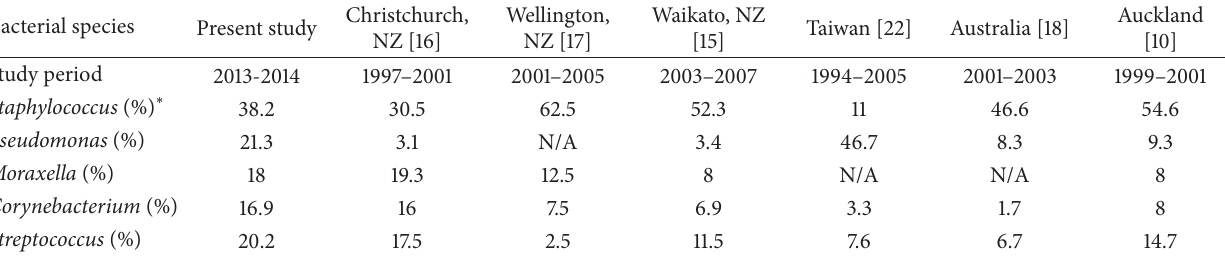
∗ Including coagulase-negative Staphylococcus aureus . N/A = not